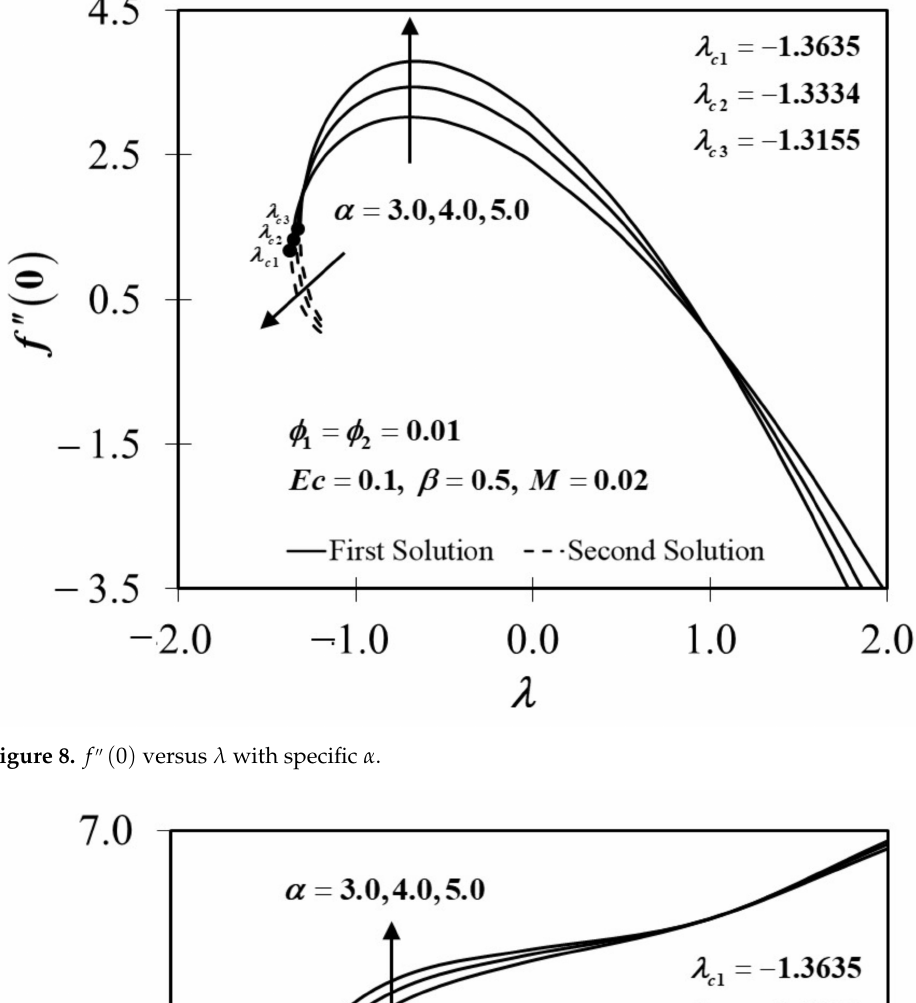
Figure 8. f (cid:48)(cid:48) ( 0 ) versus λ with specific α .